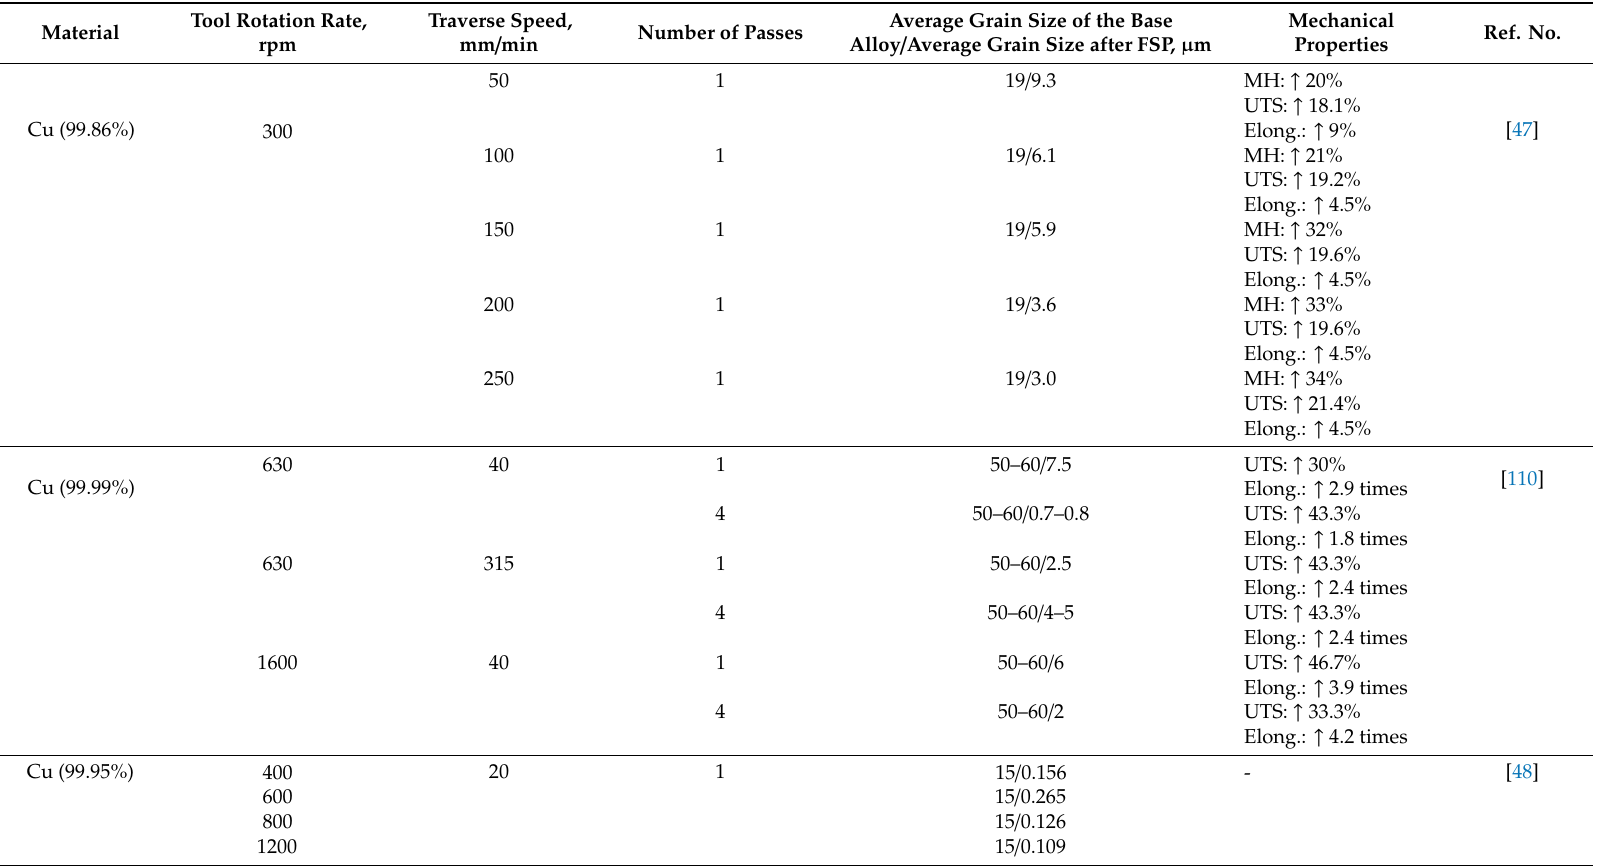
Table 2. Experimental data on FSP of copper